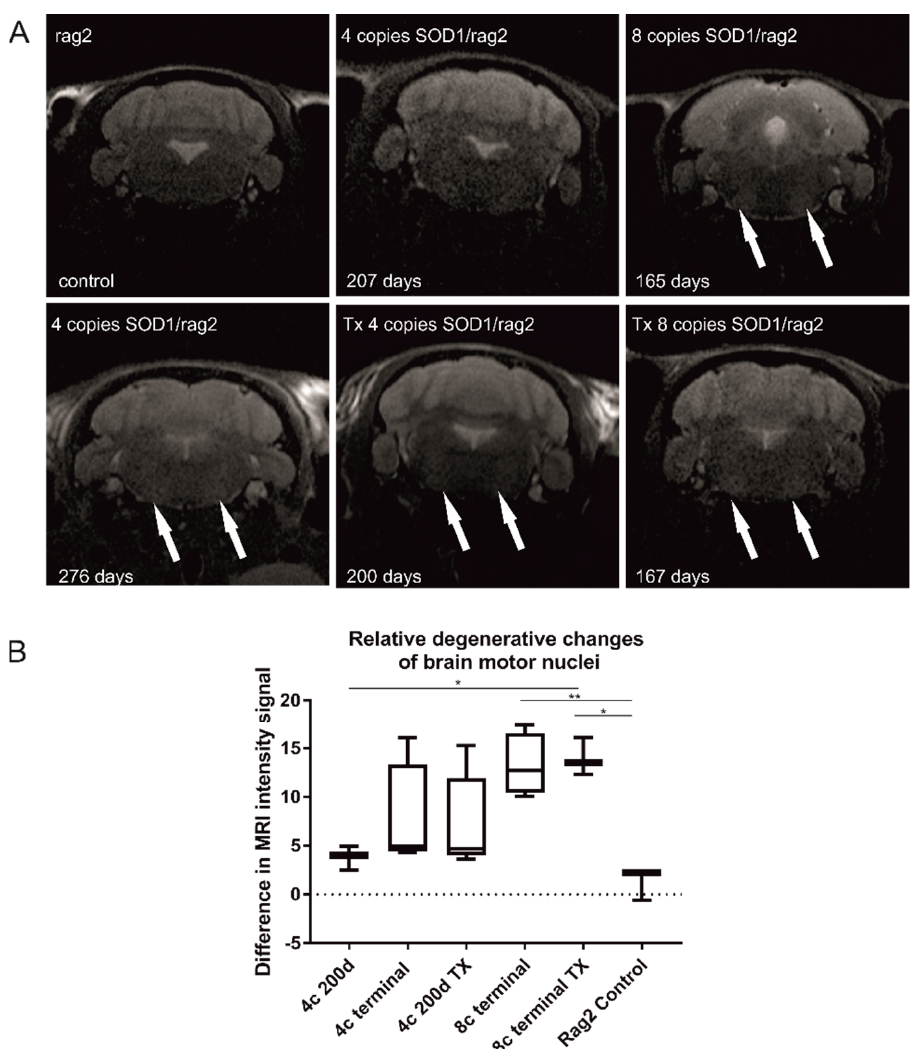
Figure 4. Longitudinal T2-weighted MRI. Hyperintensities within motor nuclei of the medulla are visible, especially in the terminal stage of the disease (165 days old 8-copy animal and 276 days old 4-copy animal, arrows). Neurodegenerative changes are also visible in transplanted animals (Tx 4-copy and Tx 8-copy mice, arrows). The difference in signal intensity between ROI in motor nuclei and ROI localized between motor nuclei—treated as control ROI ( A ). One-way ANOVA test revealed statistical significance: * p < 0.05, ** p < 0.01 presented on the graph ( B ). Values are presented as mean ± SD. Sample size within the Rag2 control group: n = 3; SOD1/rag2 nontransplanted 4-copy group: n = 7; SOD1/rag2 transplanted 4-copy group: n = 5; SOD1/rag2 nontransplanted 8-copy terminal group: n = 5; SOD1/rag2 transplanted 8-copy terminal group: n = 3.